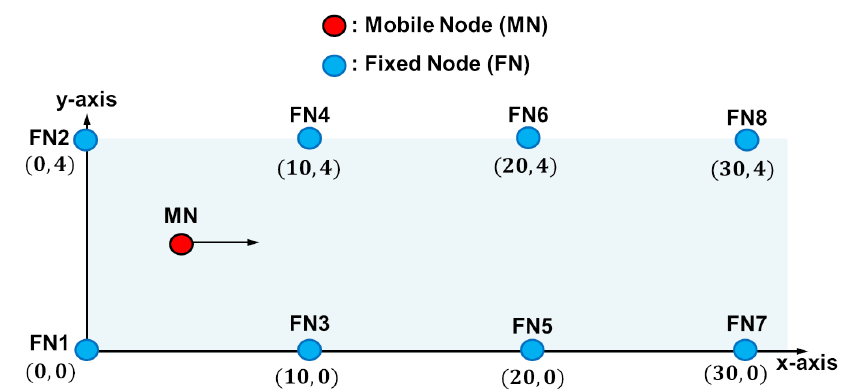
Figure 2. Indoor localization scenario of a long